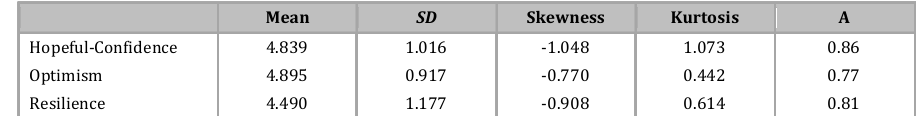
Descriptive statistics and reliabilities of the